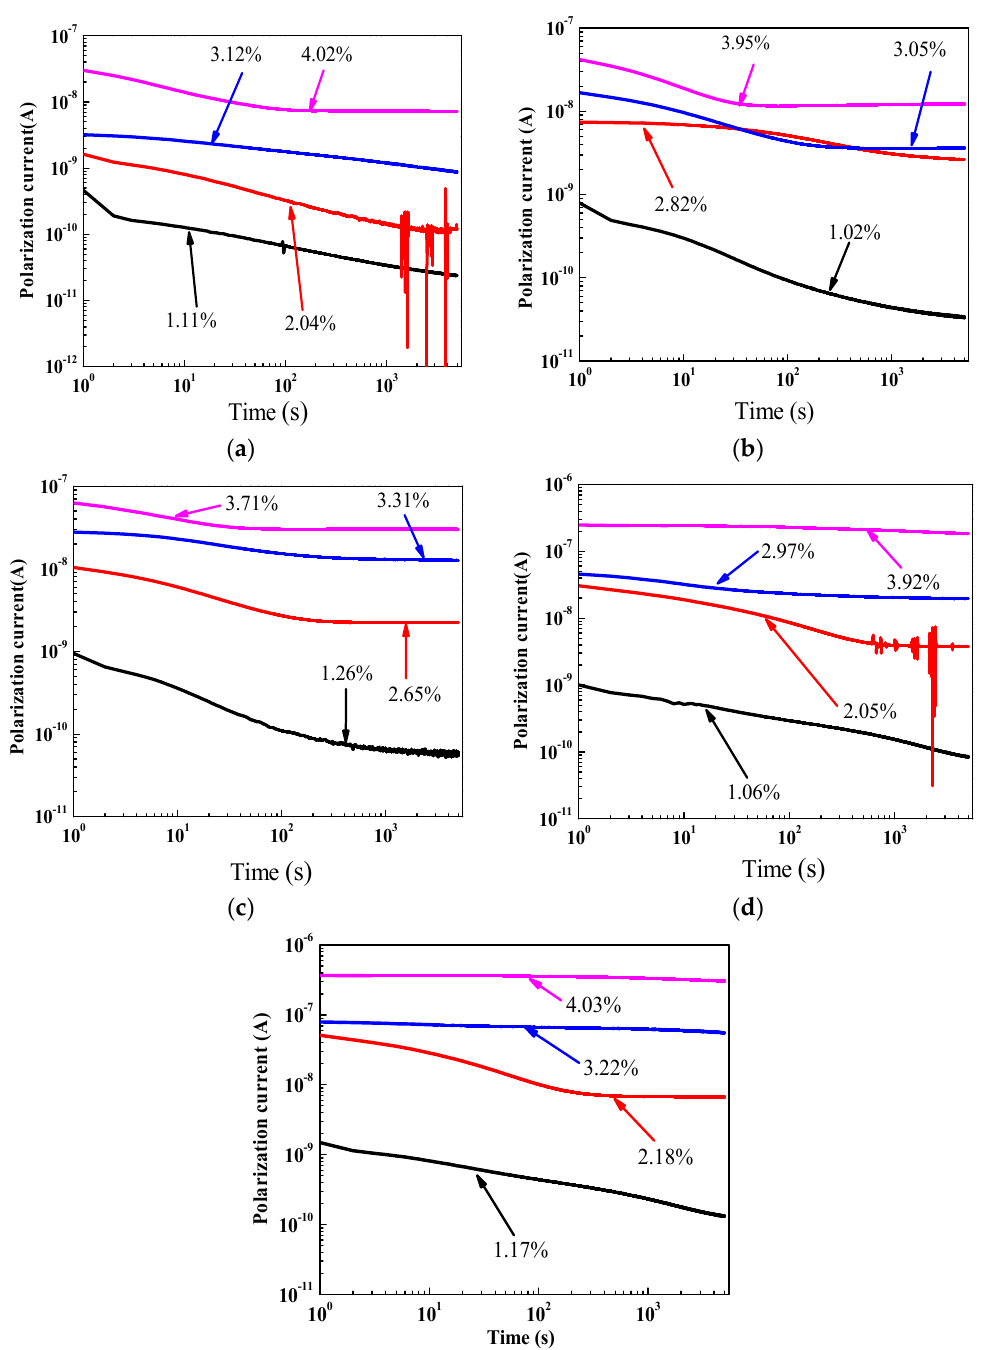
Figure 5. Polarization current measurement results of oil-immersed pressboards with different ageing conditions. ( a ) Ageing for 0 days; ( b ) Ageing for 8 days; ( c ) Ageing for 21 days; ( d ) Ageing for 32 days; and ( e ) Ageing for 42 days.